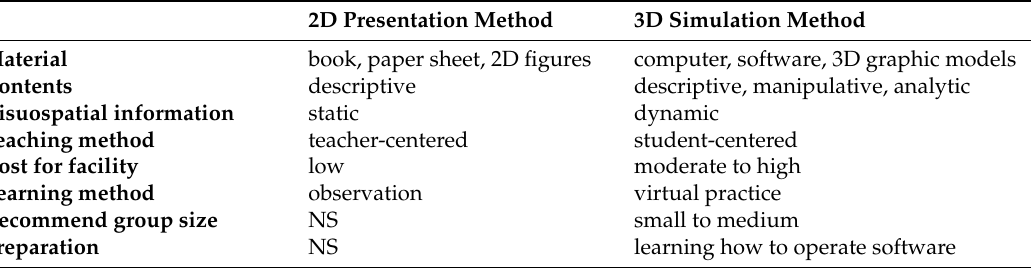
Figure 3. Three-dimensional visualization and simulation method with 3D models. Table 1. Characteristics of the teaching system used for occlusal education.